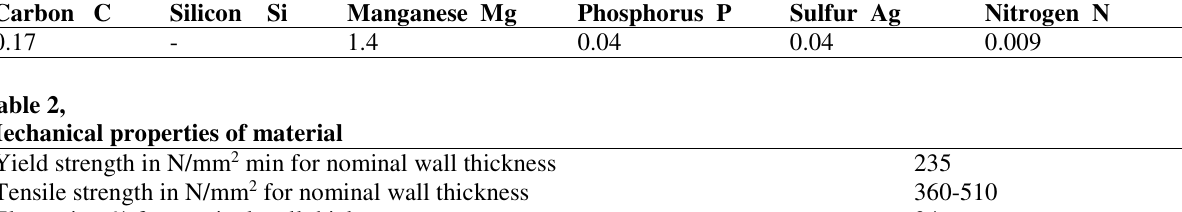
Chemical properties of material Carbon C